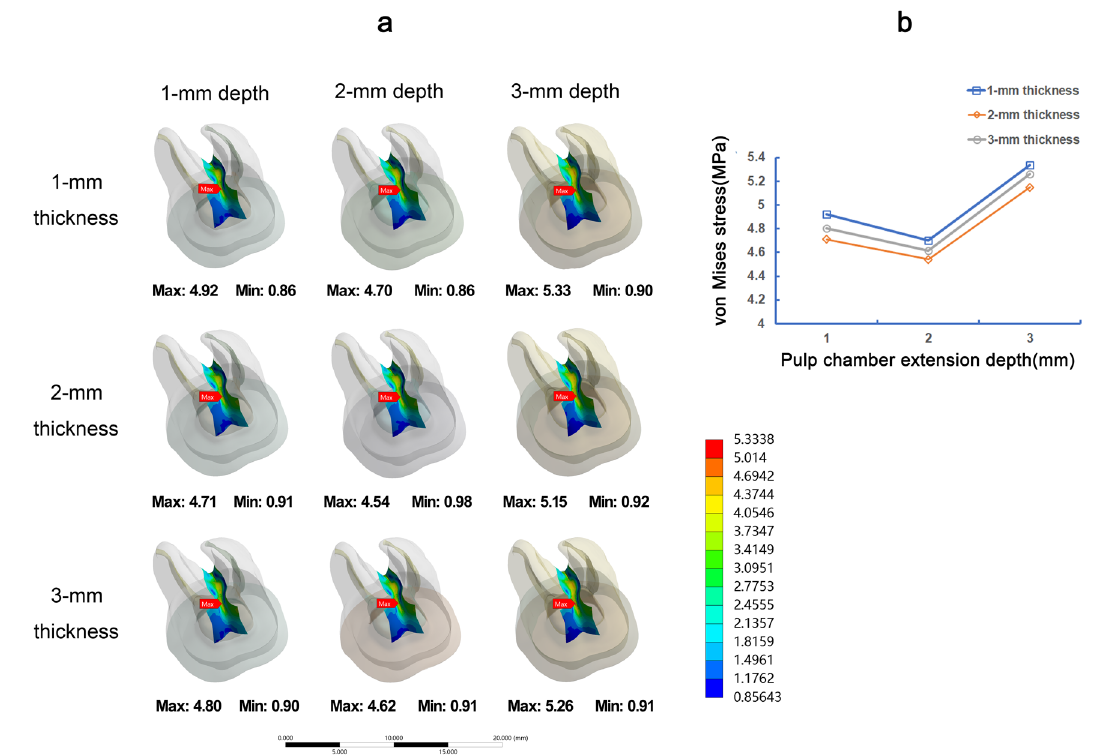
Fig. 5 The von Mises stress (MPa) distribution in root furcations in 9 FEA models under vertical load. Stress distribution plots of root fur- cations of teeth by endocrown restorations with 1-mm, 2-mm, or 3-mm pulp chamber extension depth in combination with 1-mm, 2-mm, or